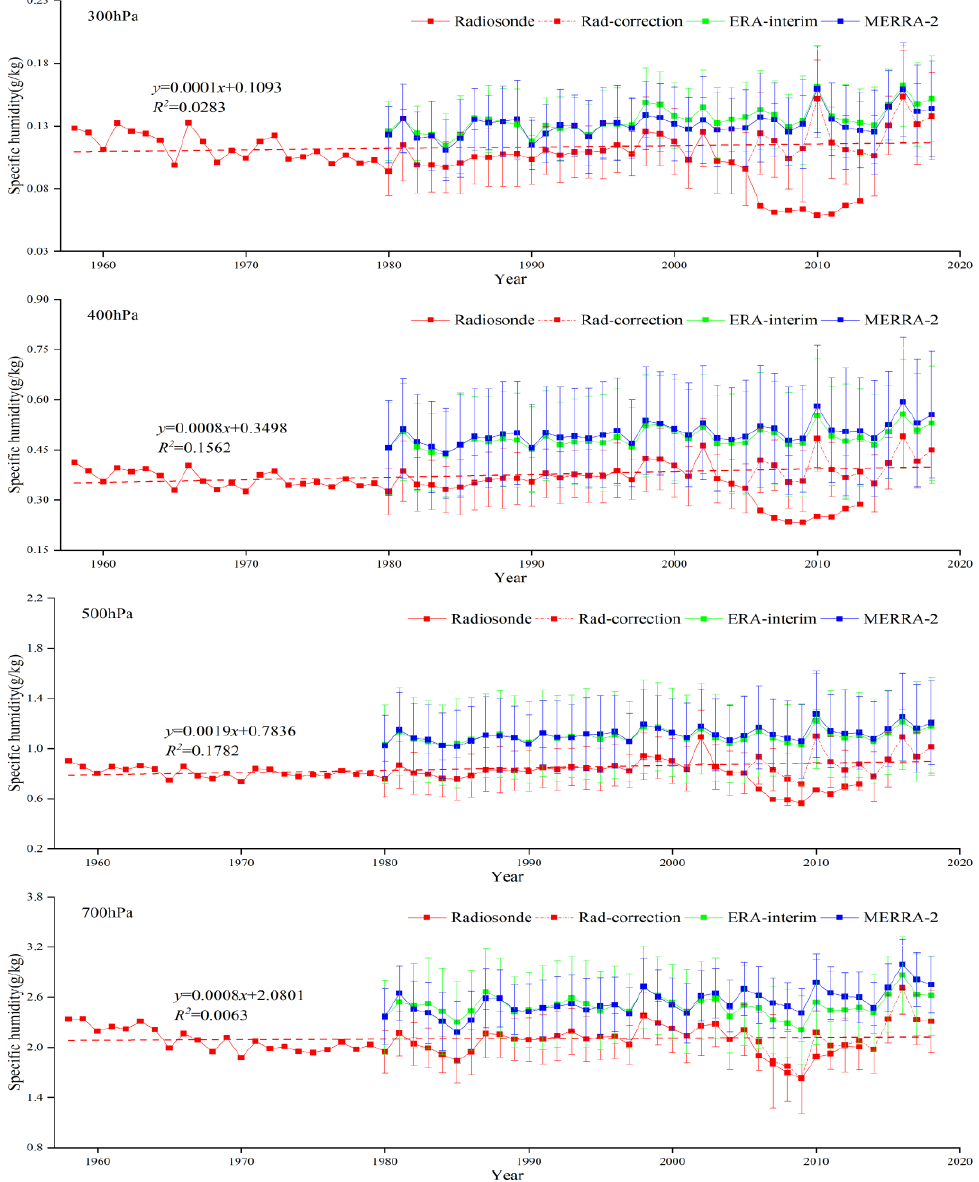
Figure 2. Temporal variation and linear trends of annual average specific humidity of various pressure-latitudes over the region during the period 1958–2018.